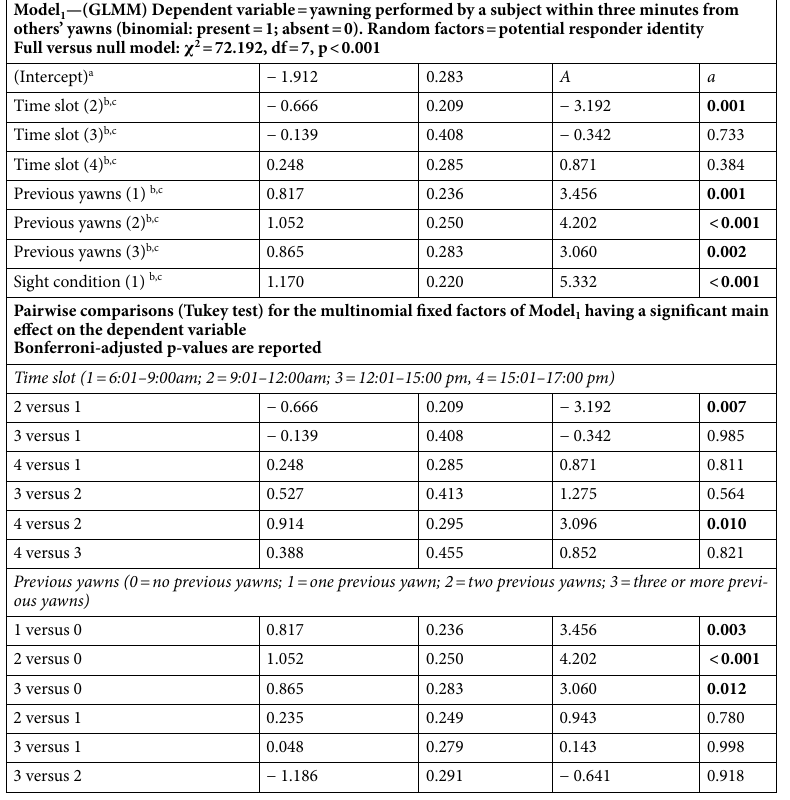
The frequencies of yawn contagion were significantly different across the three minutes from the triggering stimulus (Friedman’s test; N = 19; χ 2 = 19.279; df = 2; p < 0.001). The pairwise comparisons revealed a significant difference between first minute and the other minutes (Bonferroni-Dunn post-hoc test; third versus first min: Q = 1.263; p < 0.001; second versus first min: Q = 0.789; p = 0.045) but not between third and second minute (Bonferroni-Dunn post-hoc test: Q = 0.474; p = 0.433). Specifically, yawn contagion was highest during the first minute (Fig. 4). Video 1 shows yawning and yawning response in two study pigs lying in contact.